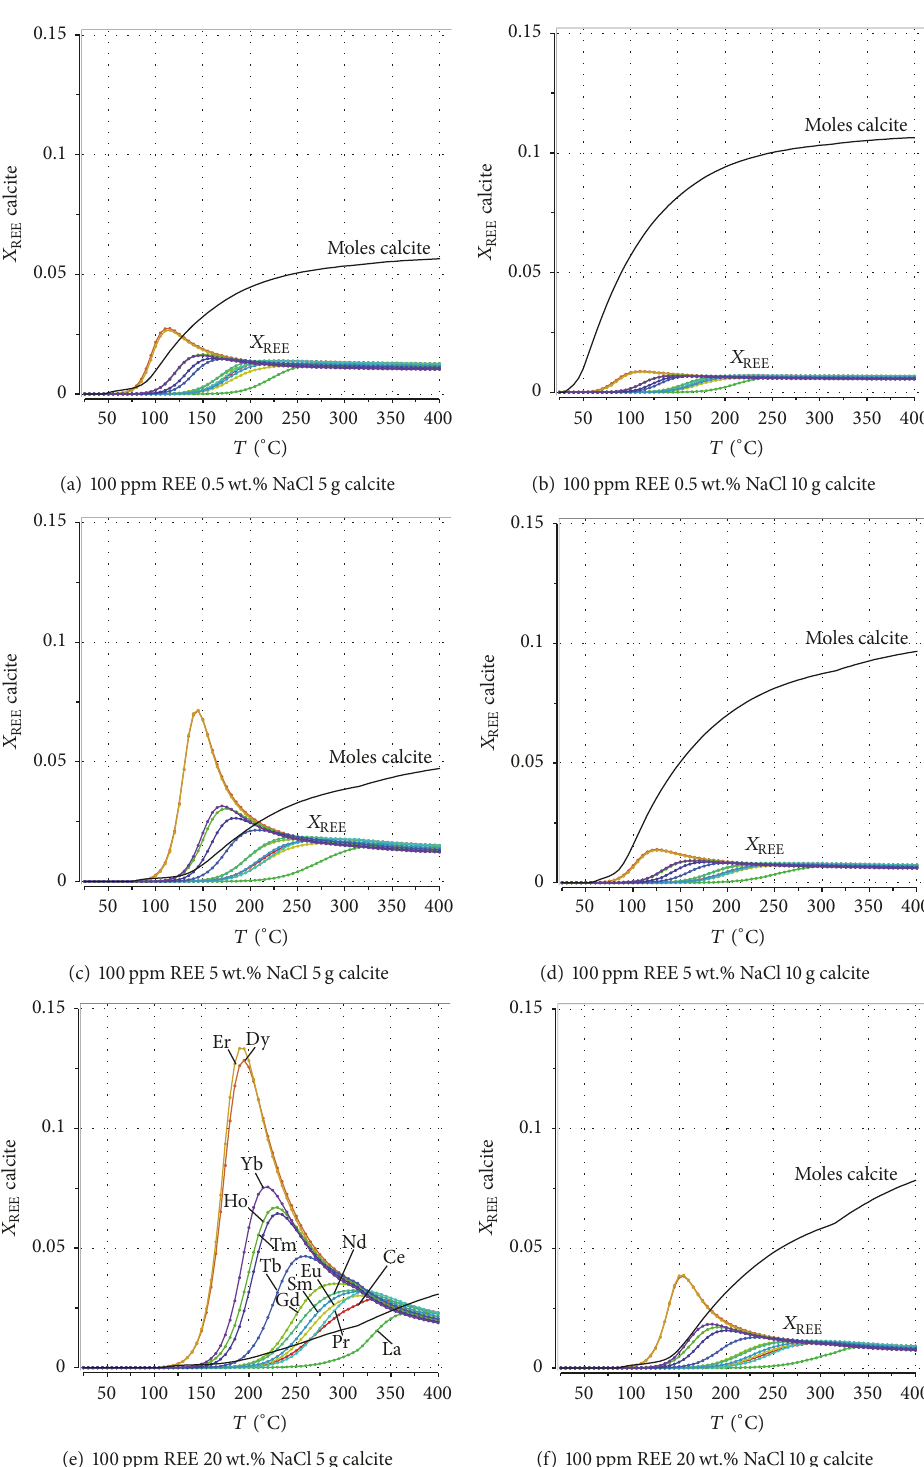
Figure 4: Rare earth element fluid-calcite partitioning Model IIa at 1kbar, showing the mole fraction of REE (𝑋 REE ) in calcite as a function of temperature, salinity (0.5, 5, and 20 wt.% NaCl), and calcite saturation. The starting fluid had a composition of 100 ppm REE, 𝑋 CO 2 of 0.1, and 5 to 10g of